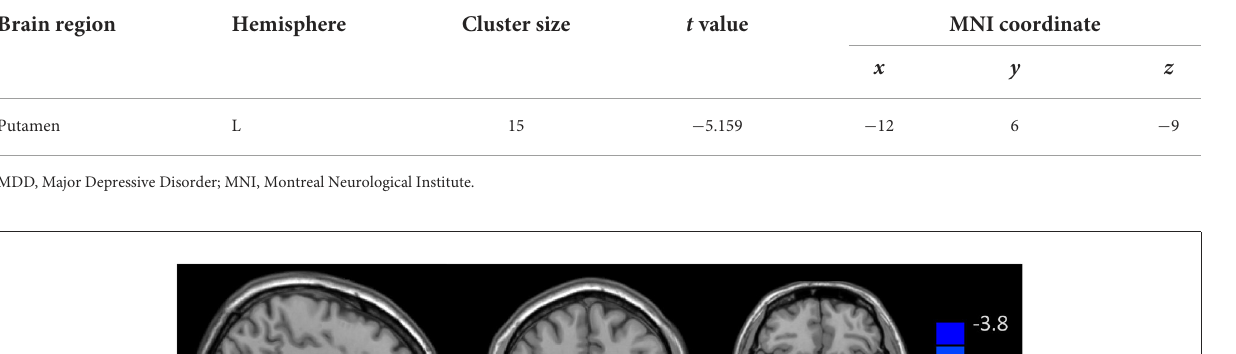
TABLE 5 Region of decreased gray matter volume in MDD with anhedonia correlated to plasma level of IL-6 (pg/ml), p < 0.05, GRF corrected . Brain region